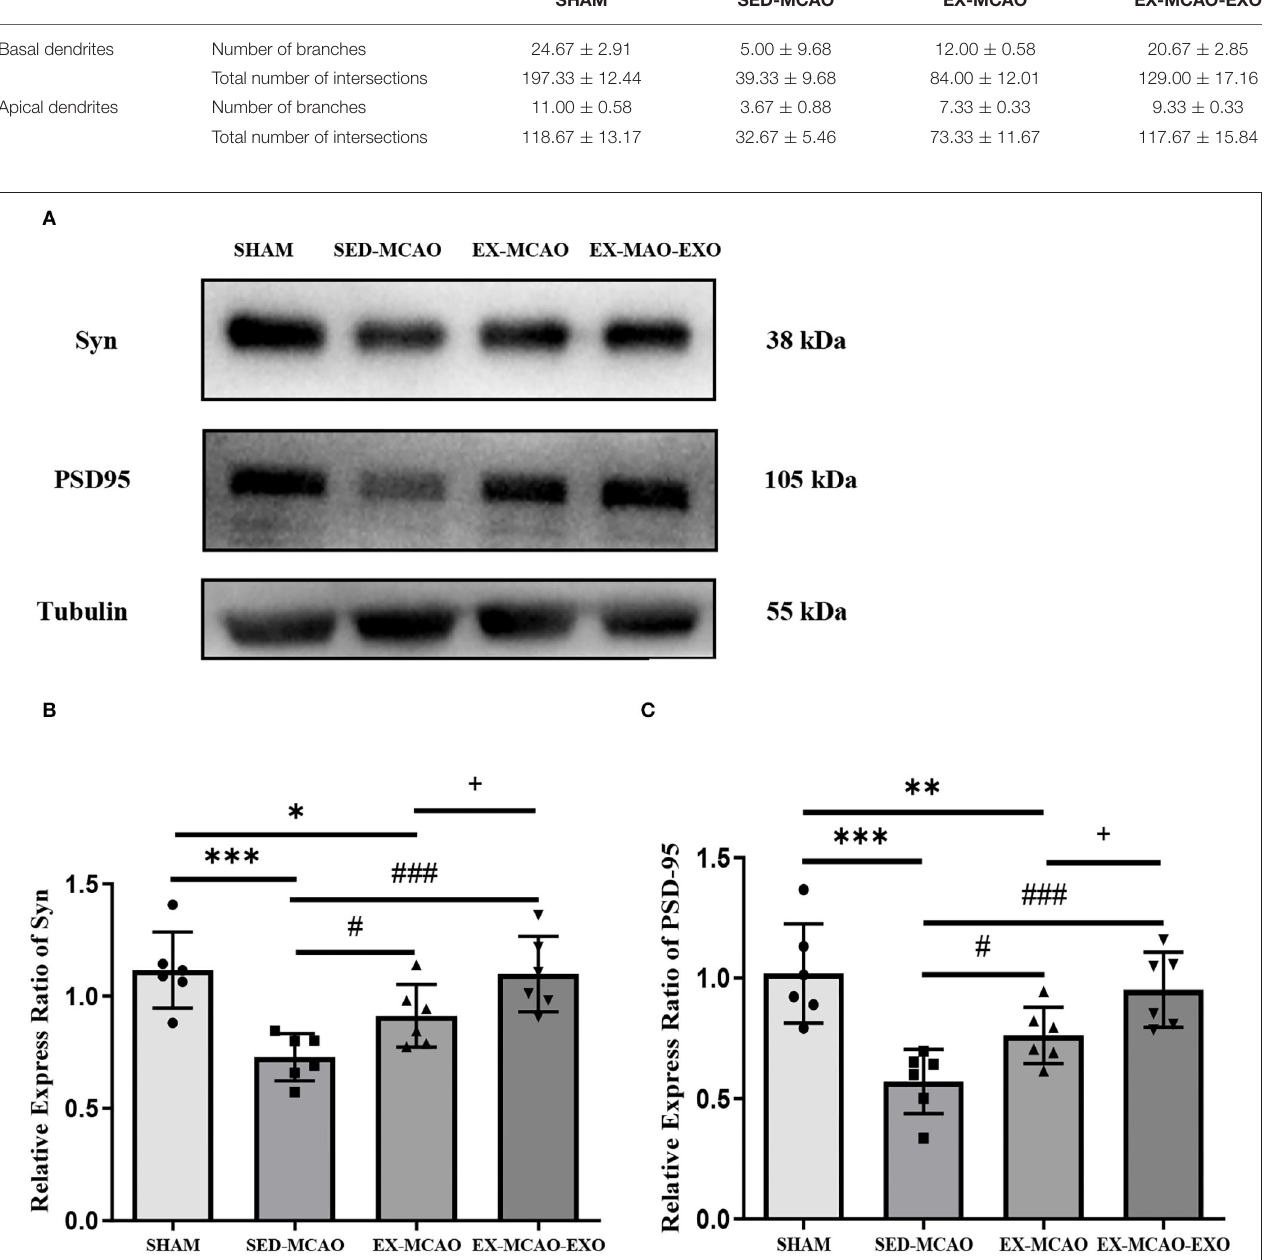
FIGURE 8 | Synaptic plasticity protein expression. (A) Western blot. (B) Syn relative expression level. (C) PSD-95 relative expression level. * P < 0.05, ** P < 0.01, and *** P < 0.001 compared with the SHAM group; # P < 0.05 and ### P < 0.001 compared with the SED-MCAO group; + P < 0.05 compared with the EX-MCAO group. Mean ± standard deviation. N =